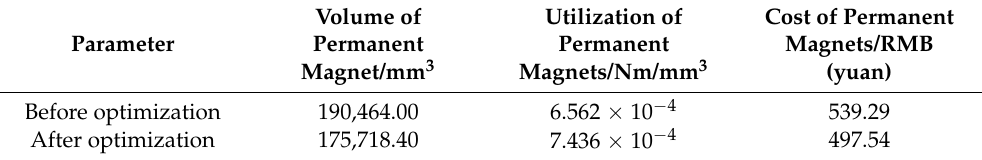
Table 13. Comparison of economic indexes of the motor before and after optimization.